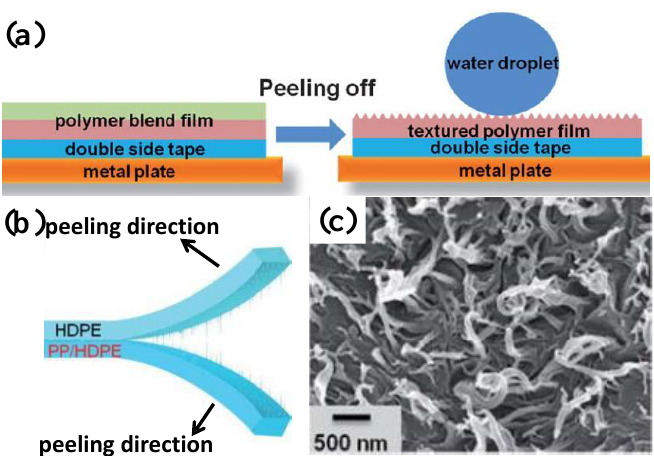
Figure 10. Illustration of using laminating exfoliation to develop a superhydrophobic structure ( a , b ) [165] and ( c ) the obtained nanofiber-like structure [165]; reproduced with permission from the Royal Society of Chemistry.